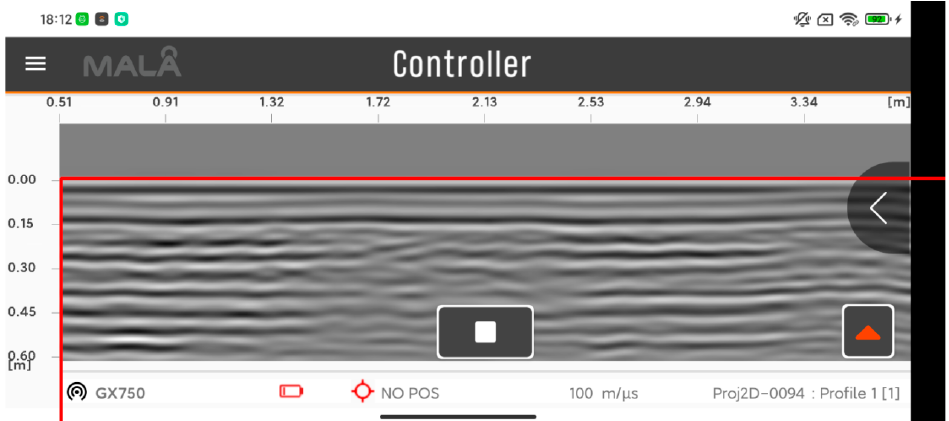
Figure 12. Reconstructed image pixel coordinate map.